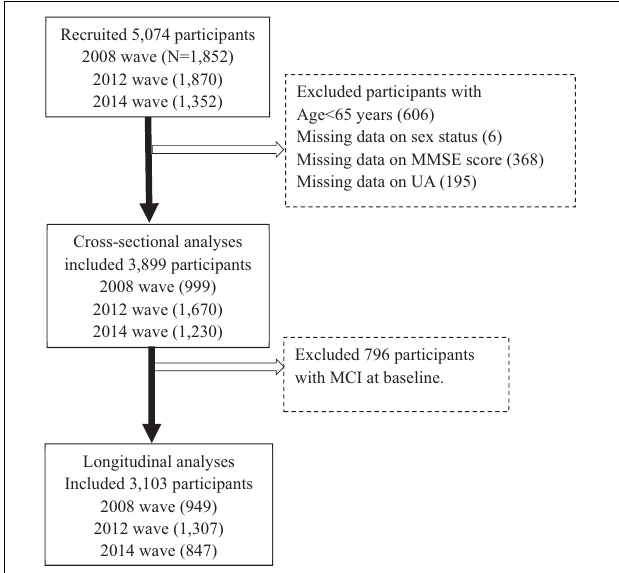
FIGURE 1 | Flowchart of study participant enrollment in this study. MMSE, Mini-Mental State Examination. UA, uric